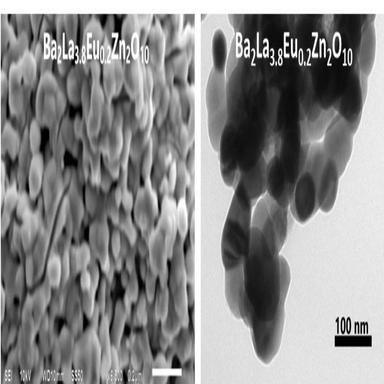
(a) and (b) respectively represent SEM and TEM micrographs of Ba2La3.8Eu0.2Zn2O10 nanophosphor representing the surface features at a sintering temperature of 1200 ◦C.